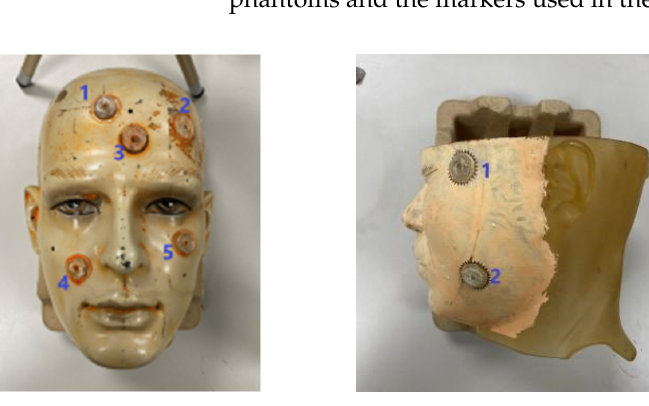
Figure 9. Head phantom 1 ( left ), and head phantom 2 ( middle and right ).